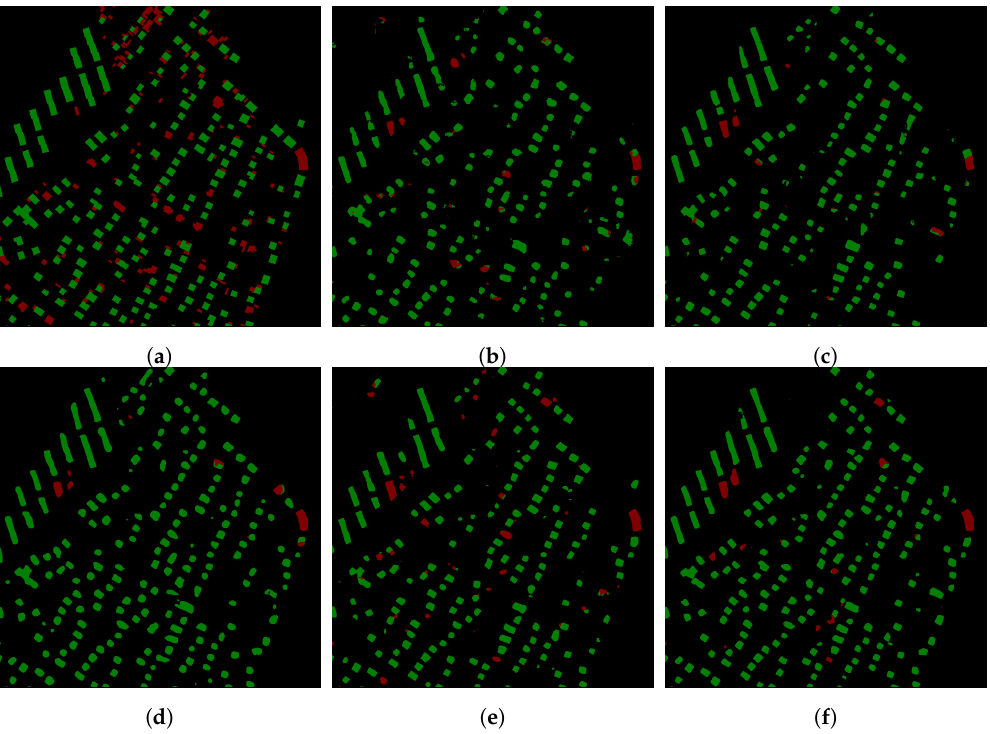
Figure 9. Visual comparison of roof classification maps over selected urban areas, generated by cGAN with least squares residuals using ( b ) the one-stream generator based on the UNet network for multiple tasks, ( c ) the one-stream generator based on the ResNet34 network for multiple tasks, ( d ) the one-stream generator based on the DeepLabv3+ network for multiple tasks, ( e ) the two-stream generator network jointly trained UNet and ResNet34 architectures for multiple tasks, and ( f ) the two-stream generator network jointly trained UNet and DeepLab architectures for multiple tasks. ( a ) depicts ground truth label